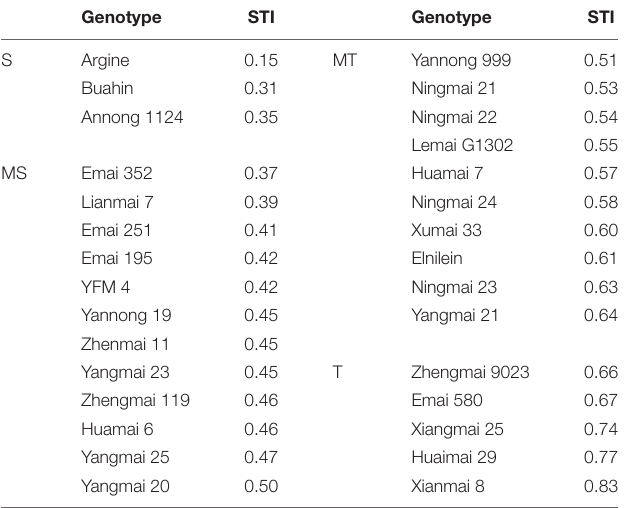
TABLE 5 | Genotype ranking according to the STI of 30 wheat varieties. Genotype